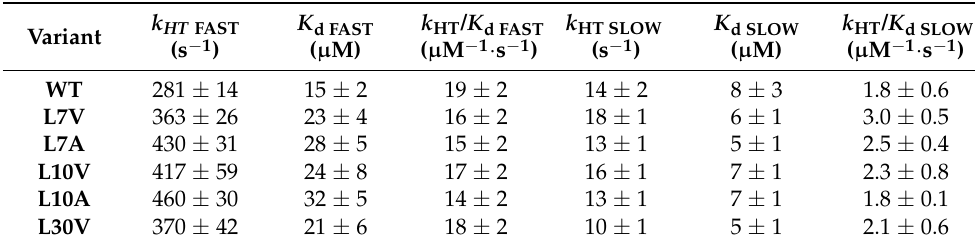
Table 1. Enzyme kinetic analysis for the reductive half reaction of NQO1 holo variants with NADH. Primary data are shown in Figure